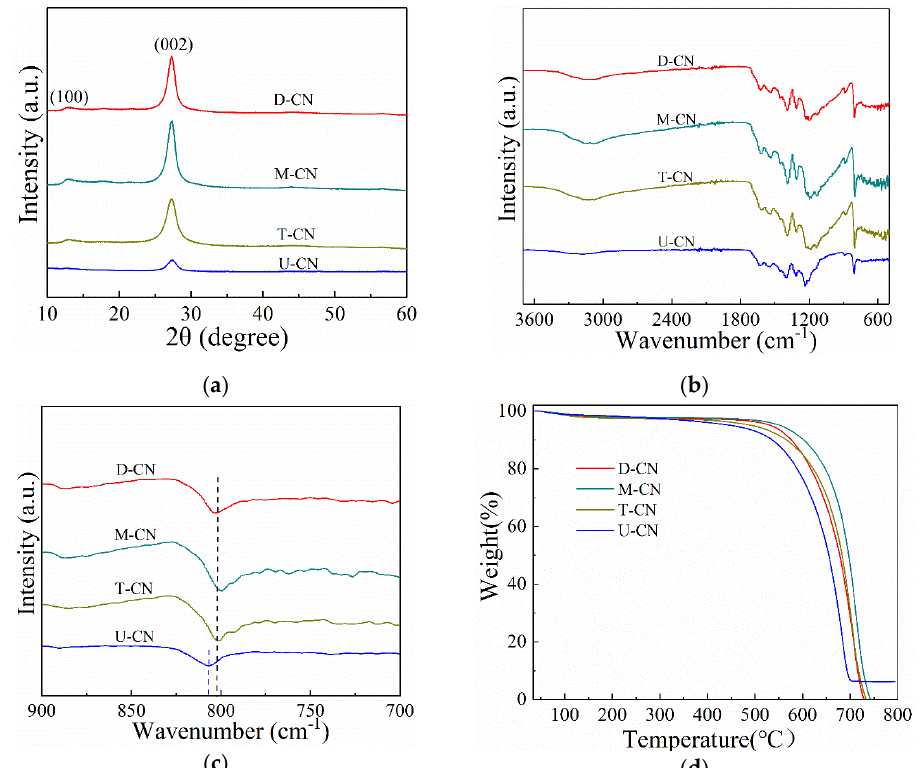
Figure 1. ( a ) XRD patterns; ( b ) FT-IR spectra; ( c ) partial enlarged FT-IR spectra, and ( d ) TG curves of g-C 3 N 4 prepared by different materials.